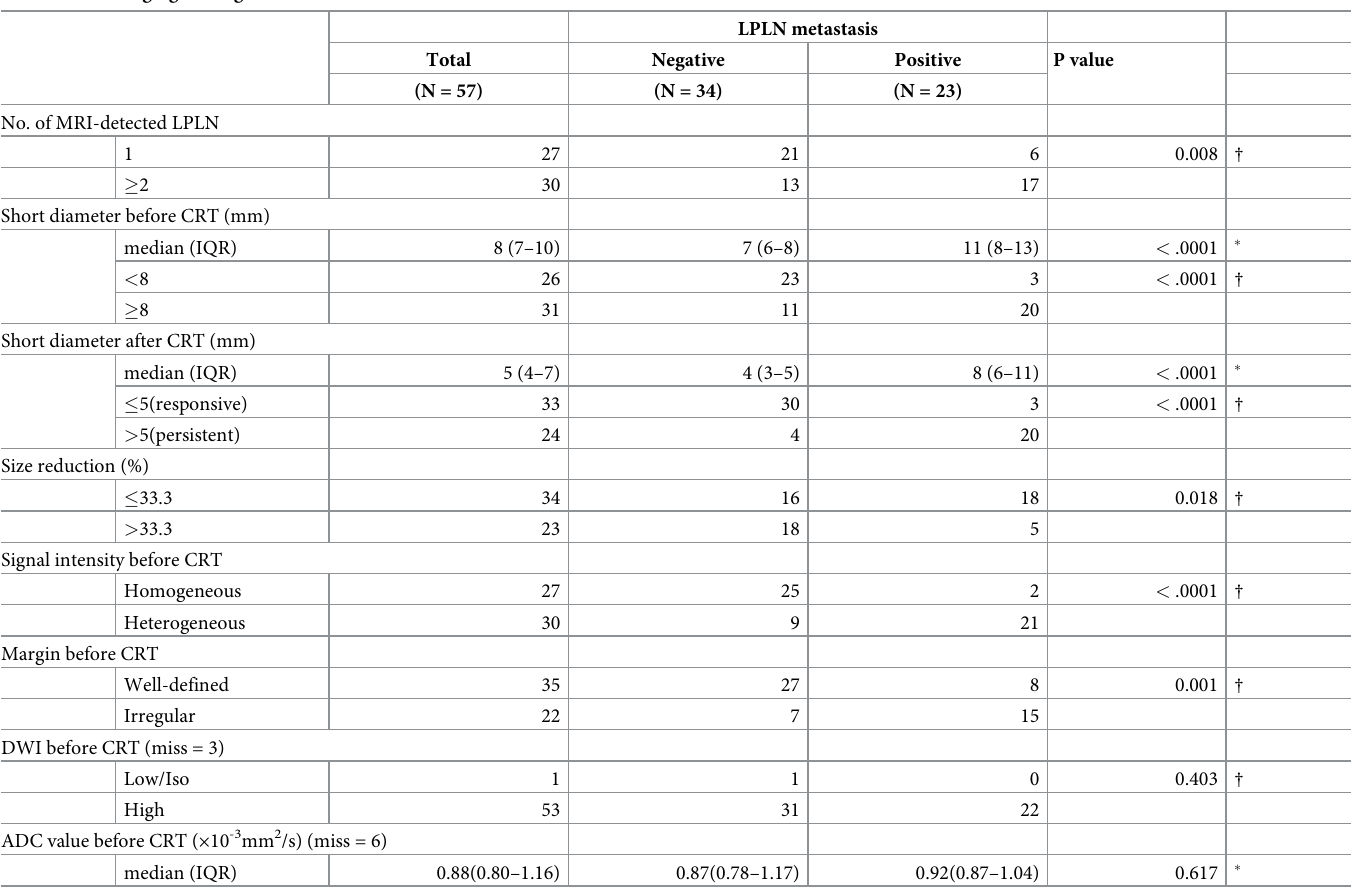
Table 2. MR imaging findings of